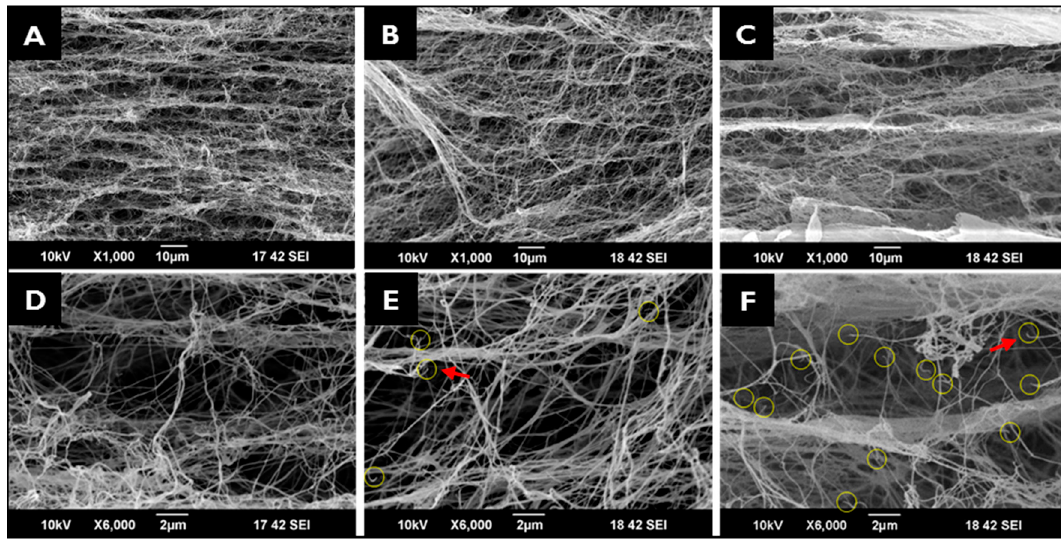
Figure 1. Cross-sectional SEM images: ( A , D ) NI-BCM; ( B , E ) 100k EI-BCM; ( C , F ) 300k EI-BCM. Yellow circles and red arrows indicate cleaved BC nanofibers in 100k ( E ) and 300k EI-BCMs ( F ).